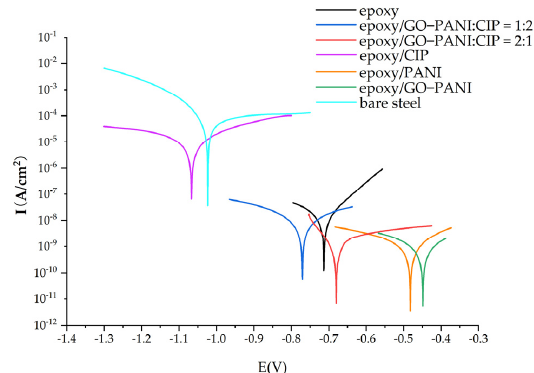
Figure 11. Potentiodynamic polarization curves for the different coatings. Table 1. The Tafel plot data for the different coatings.